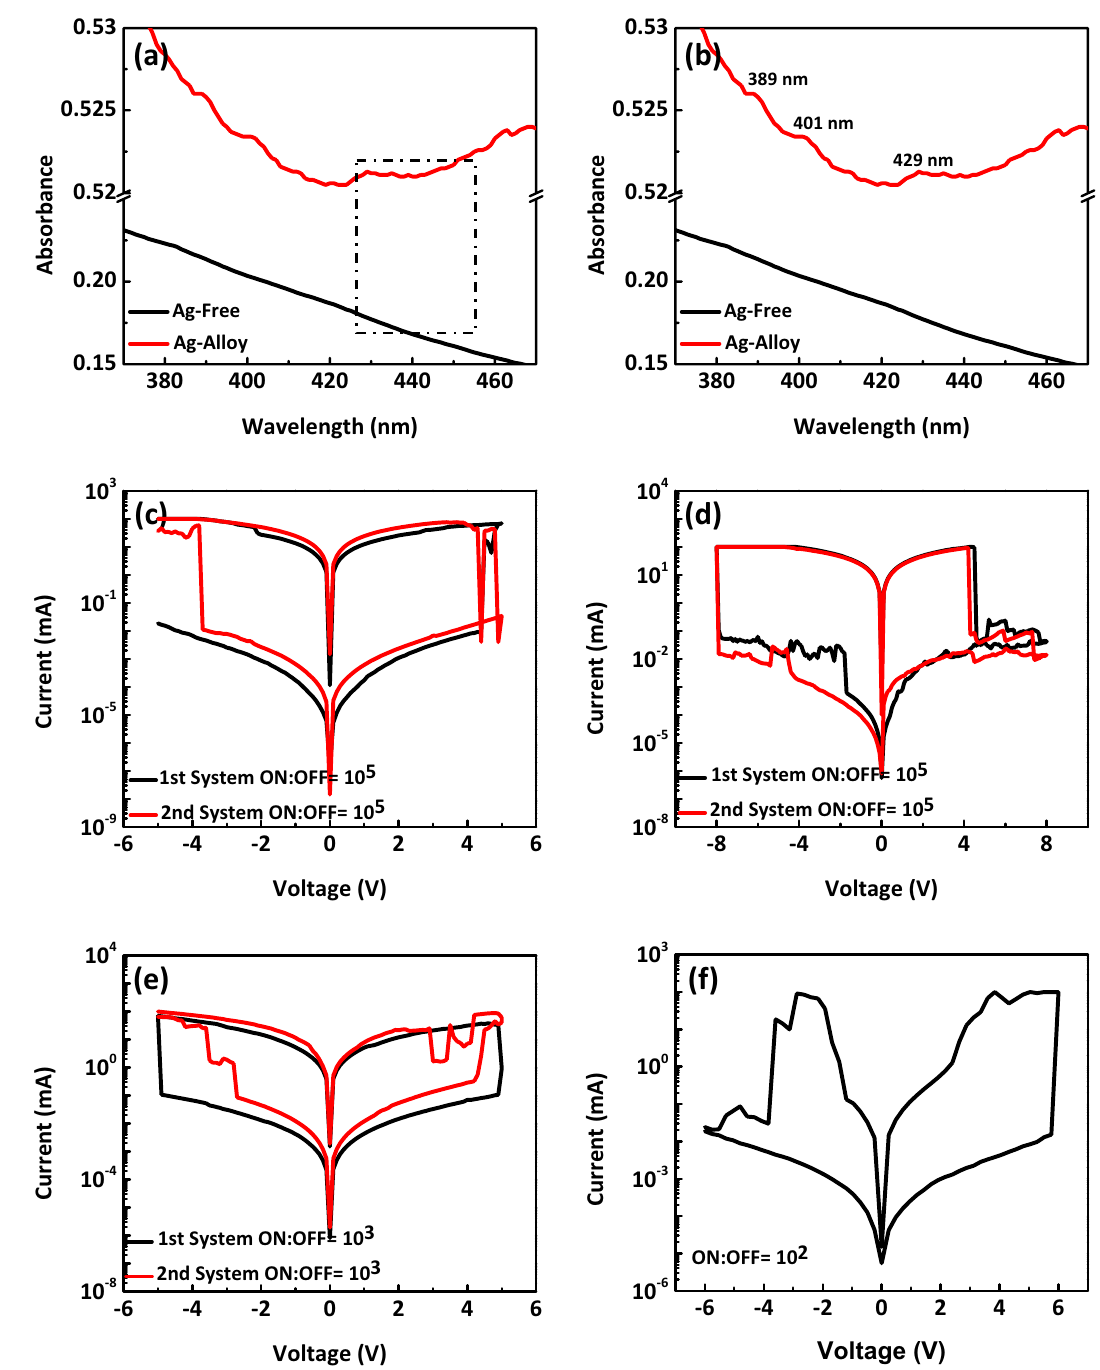
Figure 5. ( a ) UV–vis spectra of GFA-include (red plot) and GF-include (black plot) composite. ( b ) The absorbance spectra of the specified range displayed by the dashed line in ( a ). ( c – e ) I–V curves of sweeps for the fabricated second memristor devices based on GFC ( c ), GFA ( d ) and MFC ( e ) composites. ( f ) The switching characteristic for the MFC-based memristor device that has been made based on a new